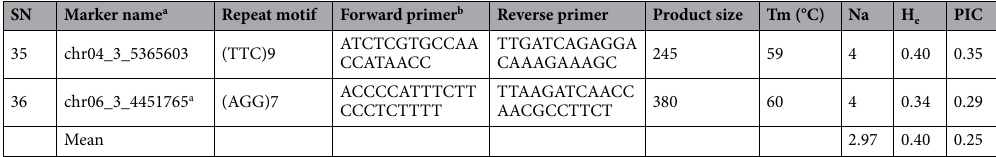
Table 3. Repeat motifs, primer sequences, annealing temperatures, and characteristics of 36 simple sequence repeat (SSR) markers in the 48 diverse spinach accessions. Na number of alleles, He expected heterozygosity calculated in GenAlEx 6.5, PIC polymorphism information content calculated in PowerMarker v3.25. a Primers were redeisgend for these SSR markers. b The M13 (CAC GAC GTT GTA AAA CGA C) tail sequences at the 5 ′ end of each primers were added, and M13 tailed forward primers used used.